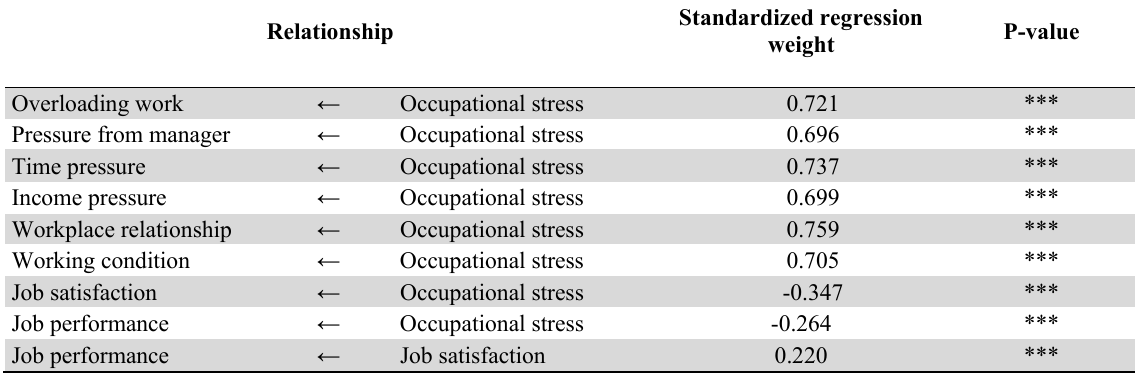
Standardized regression